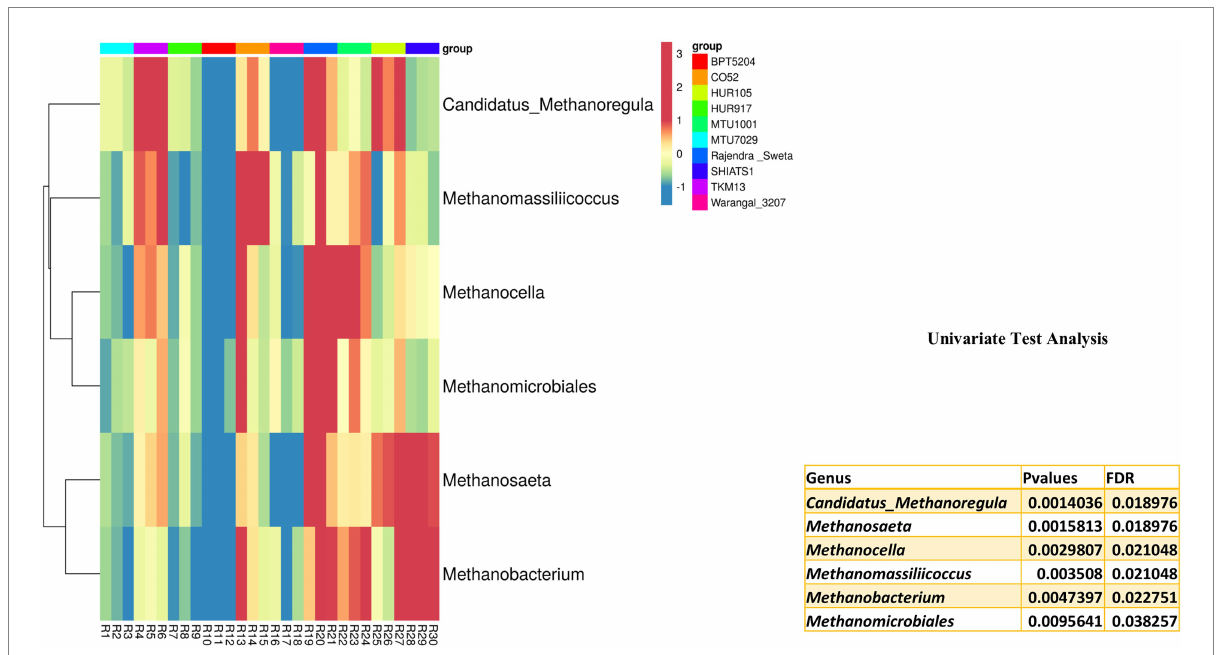
FIGURE 7 Univariate test analysis to identify important archaebacterial taxa associated with rhizo-microbiome of rice varieties, the heat map is drawn taking their relative abundance and clustering was done based on Euclidean distances, color gradient toward brown indicates high abundance, whereas lighter shades represent low